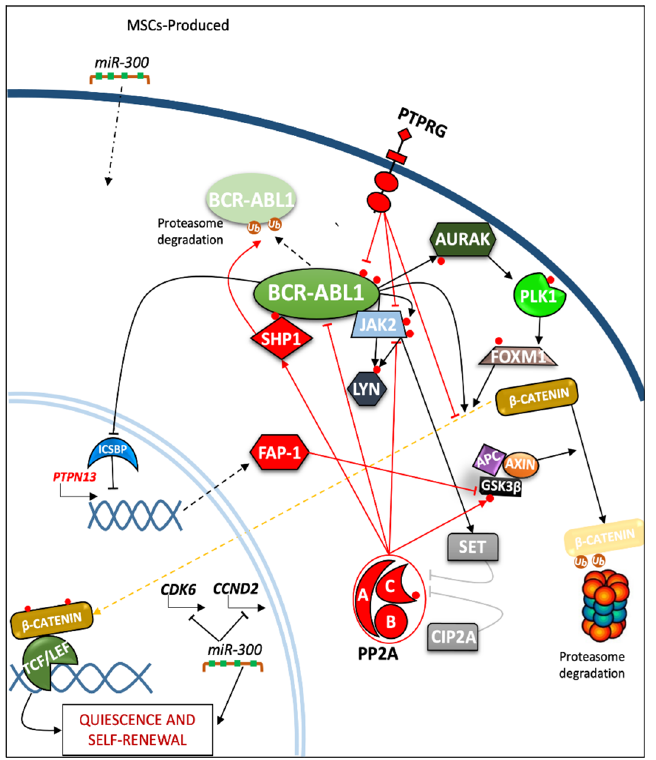
Figure 3. The major mechanisms involving phosphatases in self-renewal and quiescence processes in CML cells. FOXM1 = forkhead box protein M1; TCF = transcription Factors; LEF = lymphoid enhancer-binding factor 1.